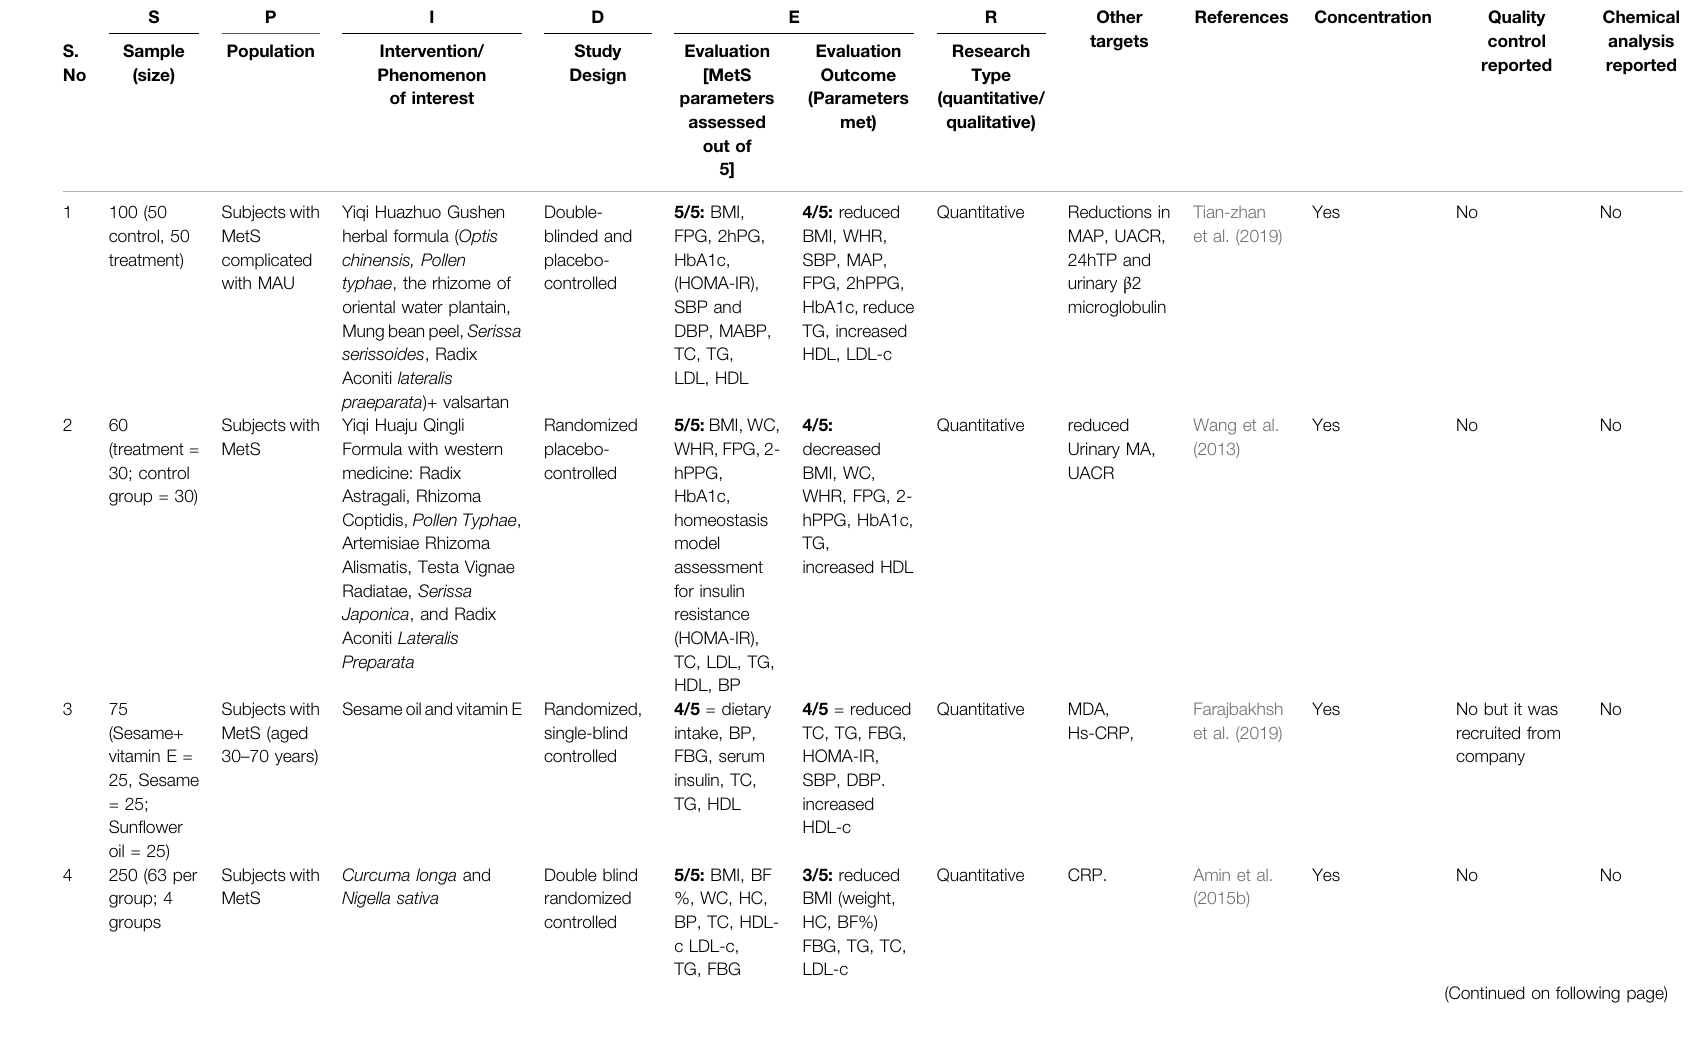
TABLE 5 | Summary of meta-analysis of polyherbal combinations used in Clinical studies in patients with MetS according to SPIDER model, concentration, quality control and chemical classi fi cations reports. S